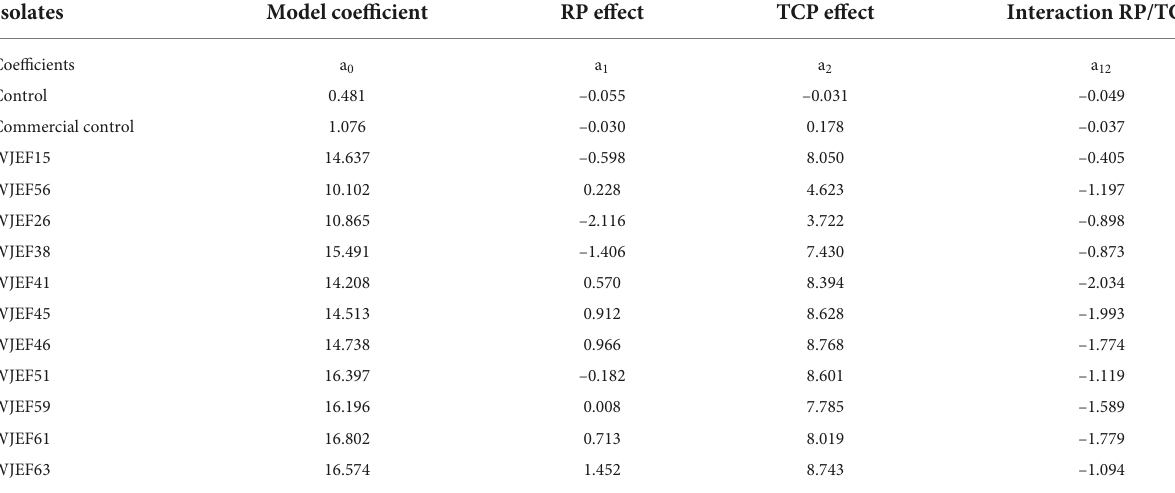
TABLE 5 Impact of phosphorus source (RP and TCP) on P solubilization in culture medium.